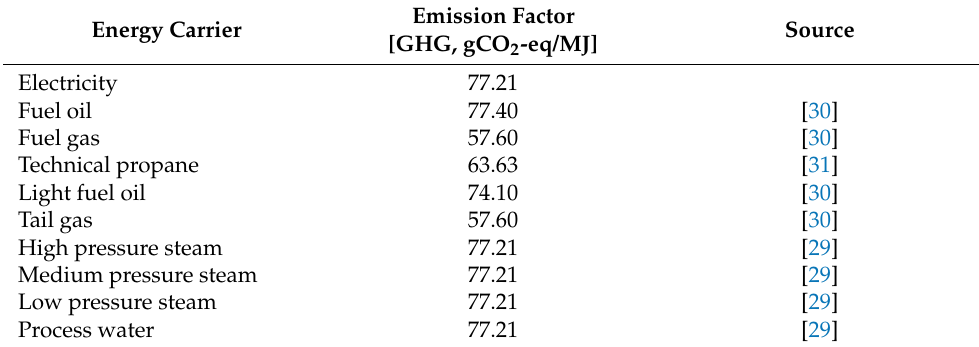
Table 1. Values of emission factors used in the study.